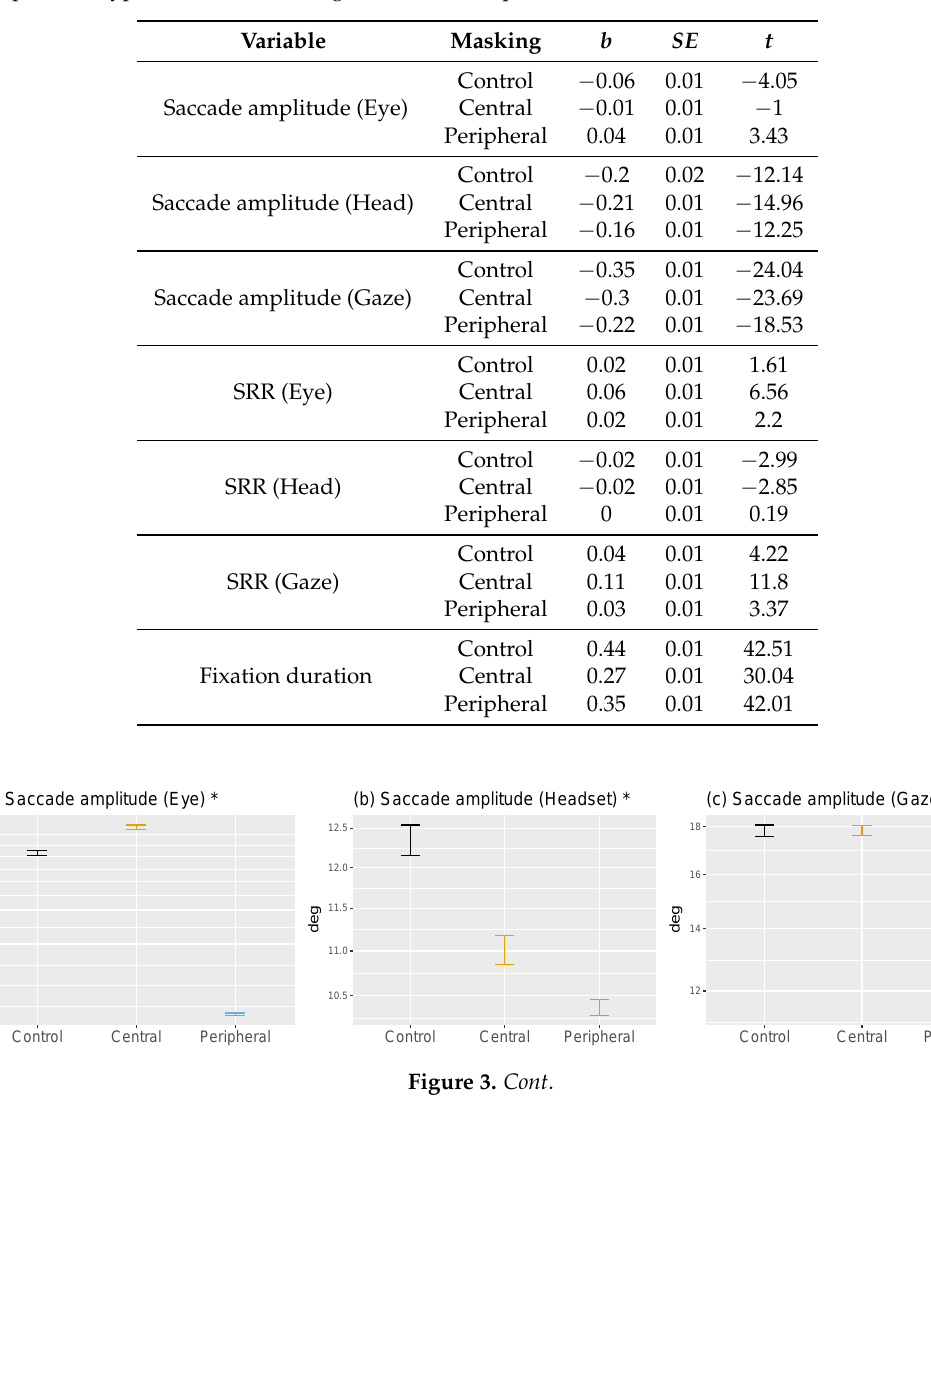
Table 1. Statistical output of the analysis of the effects of search phases on fixation duration and saccade amplitude (hypotheses Hb : scanning vs. verification